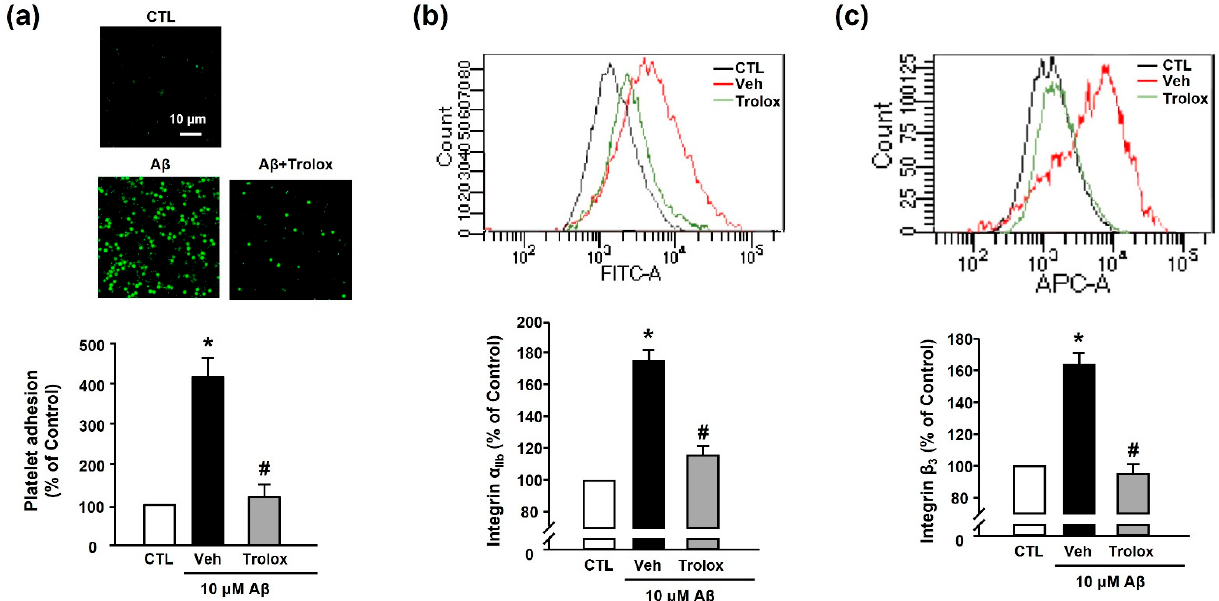
Figure 4. Effects of Trolox on A β 1–40 -induced platelet adhesion and integrin α IIb β 3 activation. ( a ) Representative fluorescence image (upper) and quantitative analysis (bottom) of platelet adhesion to fibronectin. Adhesion of platelets (green) was quantified following stimulation with 10 μ M A β 1–40 for 1 h, with or without 100 μ M Trolox pretreatment for 30 min on fibronectin-coated coverslips. Data are presented as the mean ± SEM of five experiments. Scale bars represent 10 µ m. ( b ) Integrin α IIb levels measured using flow cytometry. Representative flow cytometry histogram (upper) and quantitative analysis (bottom) of FITC–integrin α IIb -expressed platelets. ( c ) Integrin β 3 levels measured using flow cytometry. Representative flow cytometry histogram (upper) and quantitative analysis (bottom) of APC–integrin β 3 -expressed platelets. Platelets were stimulated with 10 μ M A β 1–40 for 1 h, with or without 100 μ M Trolox pretreatment for 30 min. Data are presented as the mean ± SEM of seven experiments. * p < 0.05 compared with CTL, # p < 0.05 compared with Veh.